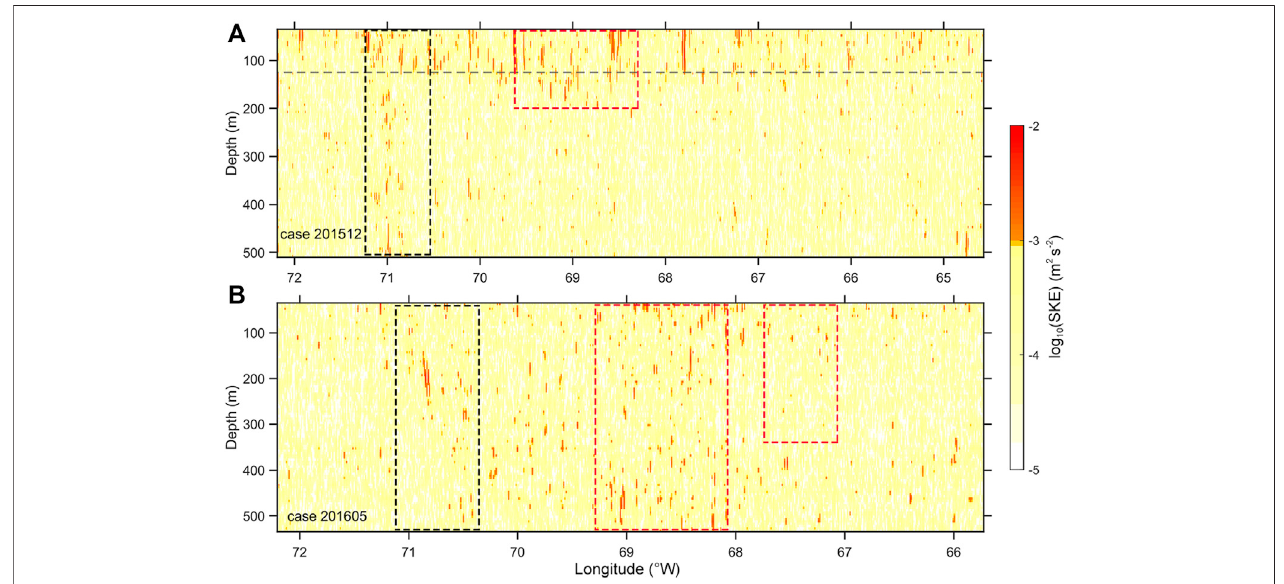
FIGURE 5 | Longitude – depth variations of log 10 (SKE) (m 2 s − 2 ) in case 201512 (A) and case 201605 (B) . The gray dashed line marks the mean mixed layer depth 125 minwinter. TheblackdashedboxesmarktheGulfStreamposition,whilethereddashed boxesrepresentthepositionofmesoscaleeddies thatgenerate/in fl uence submesoscale motions.